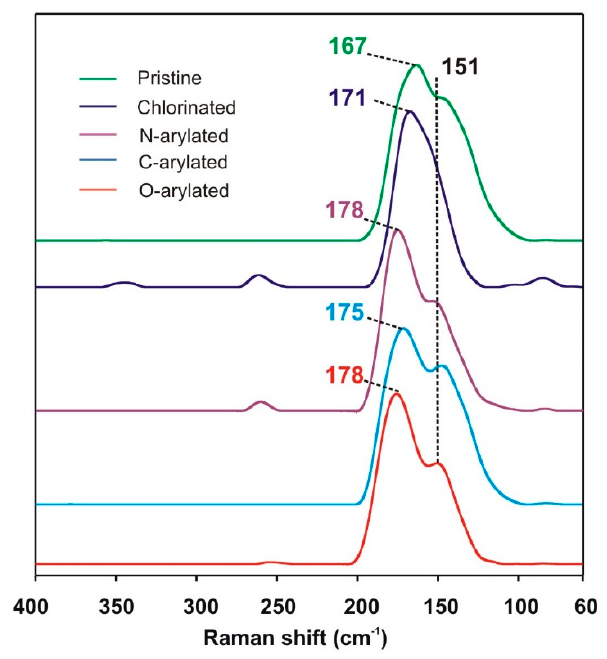
Figure 3. The Radial Breathing Mode (RBM) region of pristine and functionalized SWCNTs.